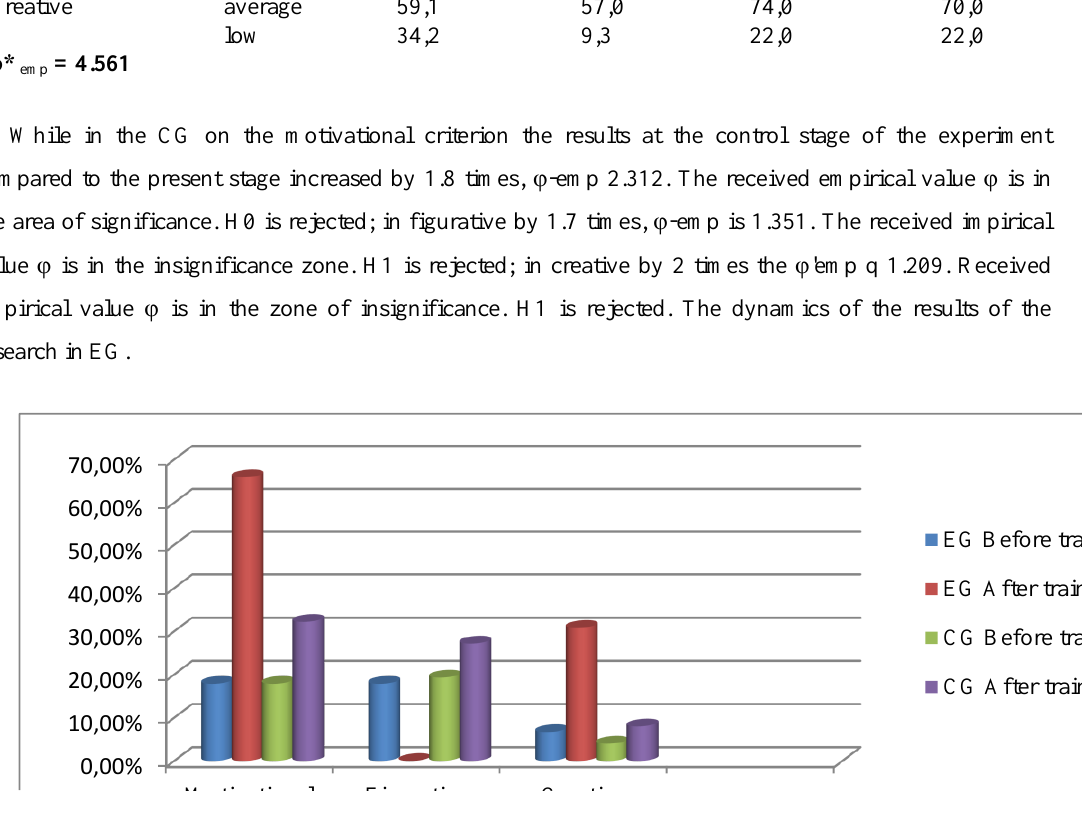
Figure 1. The dynamics of the results of study in EG and CG before and after training at a high